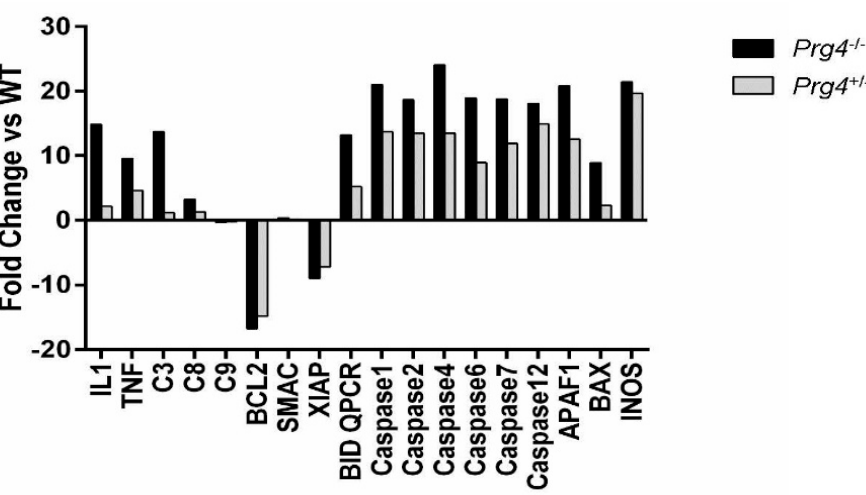
Figure 3. Real-time PCR of intrinsic and extrinsic apoptosis mediators from chondrocytes of knee articular cartilage from three Prg 4 − / − and Prg 4 +/ − mice. The ∆∆ C t calculation represented as a log2 fold change relative to the Prg 4 +/+ genotype is shown. Levels of caspase-3 and IL-1 β expression are greater in chondrocytes from Prg 4 − / − than Prg 4 +/ − littermates, however expression levels of caspase-8 and 9 are unchanged. Levels of factors involved in intrinsic apoptosis, including Bax , BH3 interacting-domain death agonist ( Bid ) and Caspase-2 all show greater expression in Prg 4 − / − as compared to Prg 4 +/